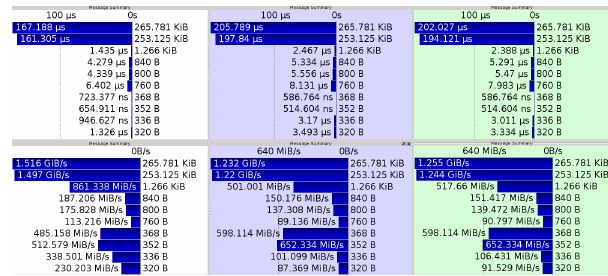
Figure 7: Message summaries (top: average mes- sage transfer time per message size, bottom: aver- age message bandwidth per message size) for the topologies under investigation (left: 4 × 4 × 4 , center: 16 × 4 × 1 , right: 64 × 1 × 1